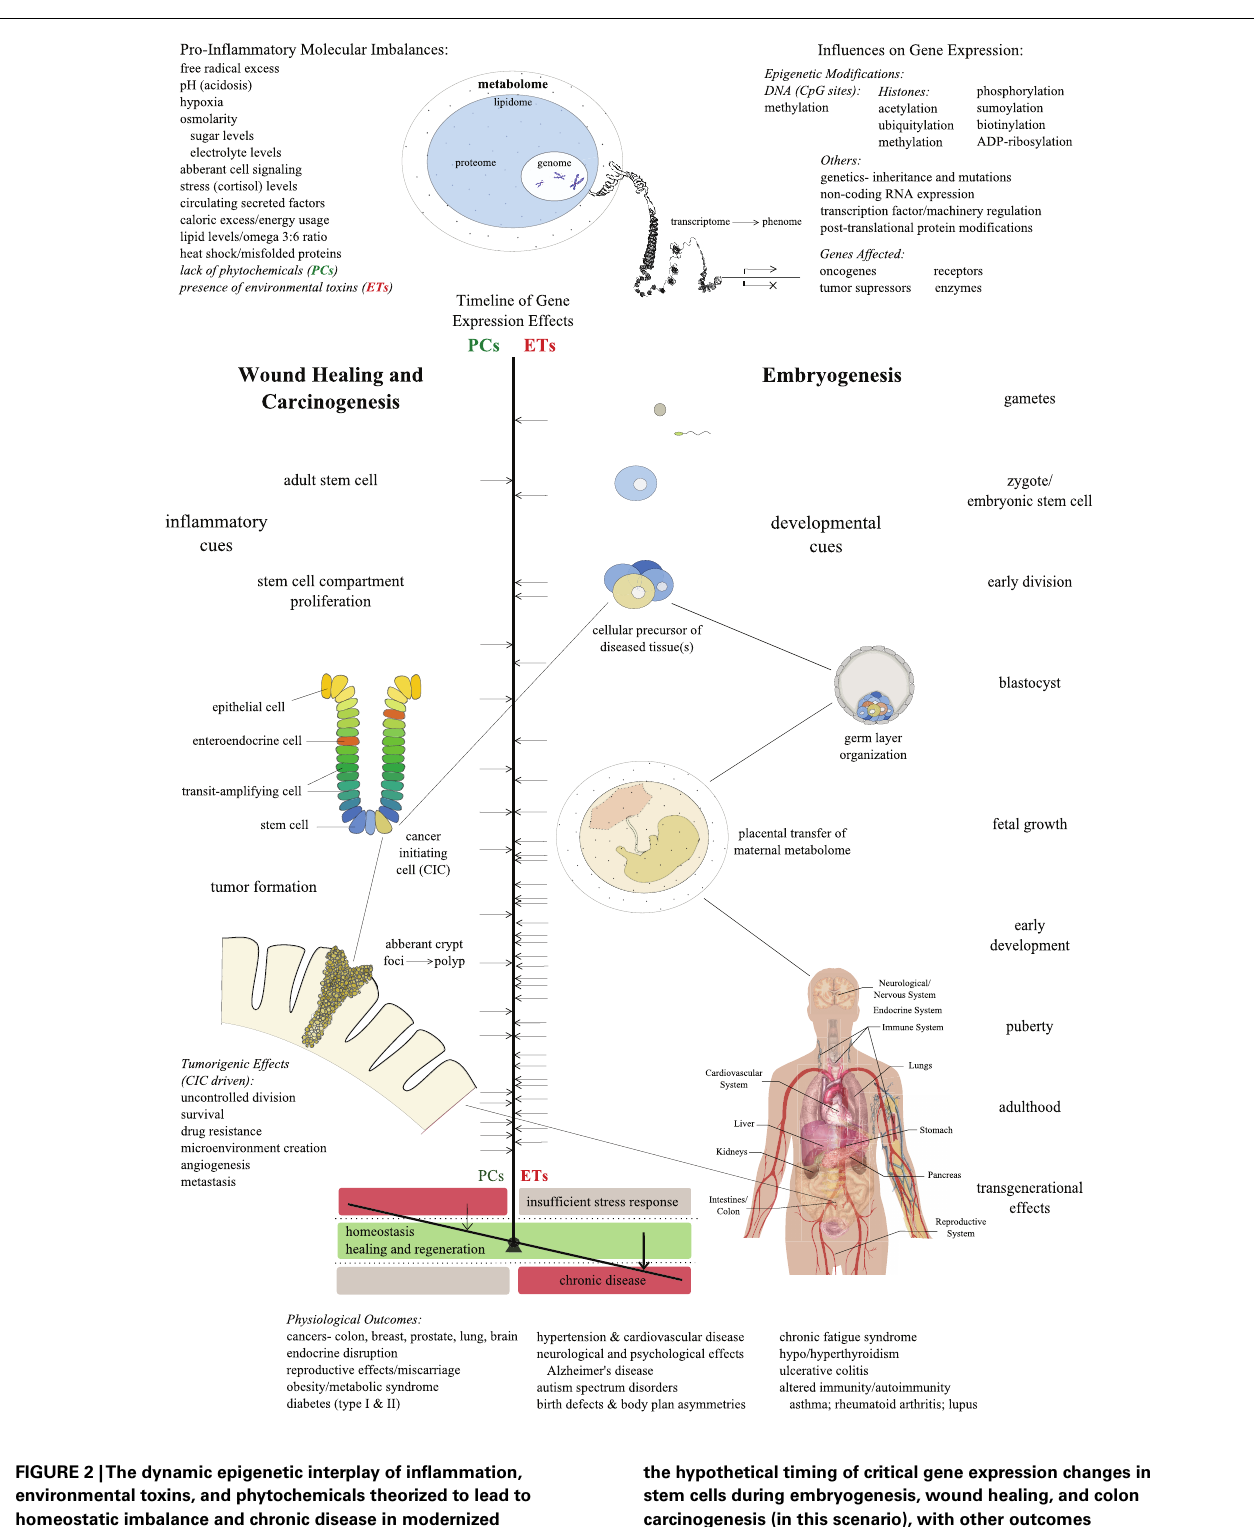
FIGURE 2 |The dynamic epigenetic interplay of inflammation, environmental toxins, and phytochemicals theorized to lead to homeostatic imbalance and chronic disease in modernized societies; the manifestation and extent of which depends upon